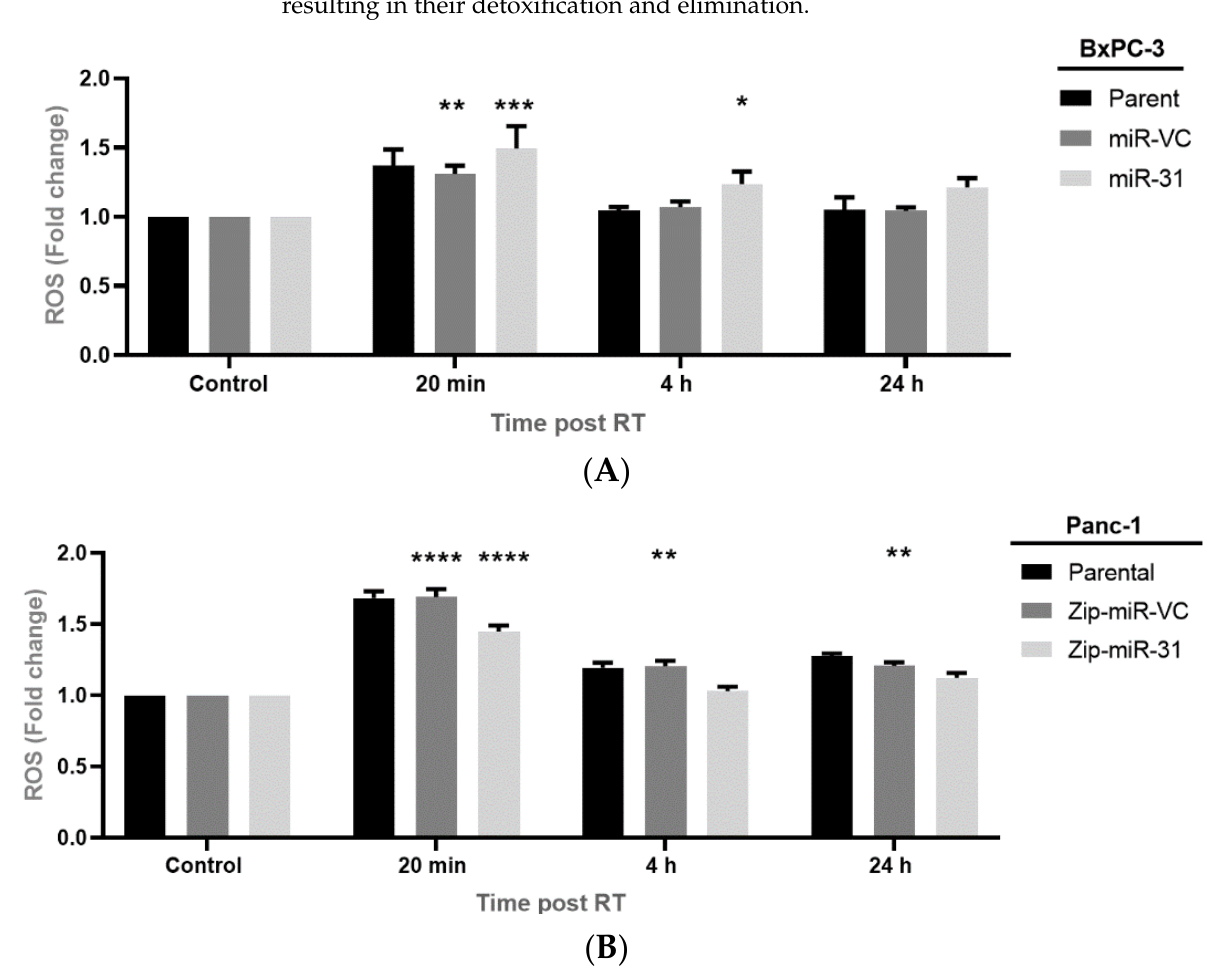
Figure 7. Manipulating miR-31 alters ROS levels in PDAC cell lines. ( A ) ROS levels were assessed 20 min, 4 h, and 24 h post-radiation treatment (RT) and compared to the untreated control (0 Gy). Overexpressing miR-31 in BxPC-3 cells resulted in a significant increase in ROS levels 20 min (*** p < 0.001) and 4 h (* p = 0.0295) post-RT. Meanwhile, miR-VC cells displayed a significant increase in ROS levels at 20 min only (** p = 0.0018) post-RT, which had returned to baseline levels 4 h and 24 h post-RT. ( B ) Similarly, ROS levels were assessed 20 min, 4 h, and 24 h post-radiation treatment (RT) and compared to the untreated control (0 Gy). In miR-31-suppressed Panc-1 cells, ROS levels significantly increased 20 min (**** p < 0.0001) post-RT but returned to baseline 4 h and 24 h post-RT.